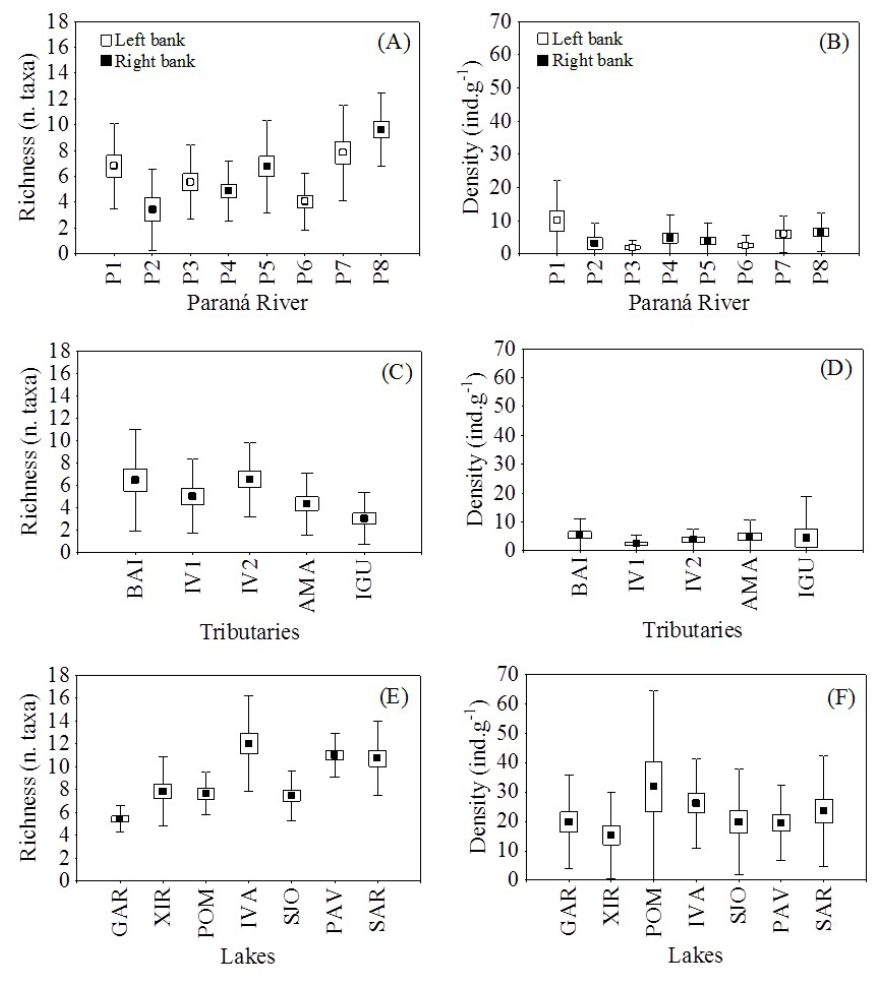
Figure 4. Mean values, deviation and standard error of richness and density of ostracods in (A, B) Paraná River, (C, D) tributaries and (E, F) lakes in the river-floodplain system of the Upper Paraná